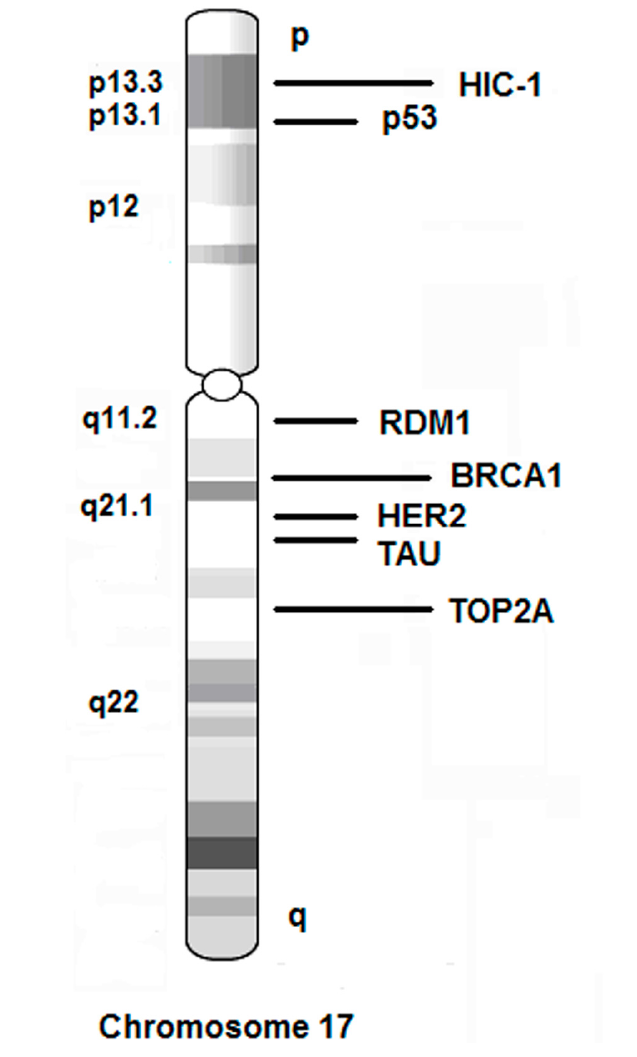
Figure 1. Schematic diagram of chromosome 17 and several important molecular markers for breast cancer. Gene names are listed on the right side and resided regions are listed on the left